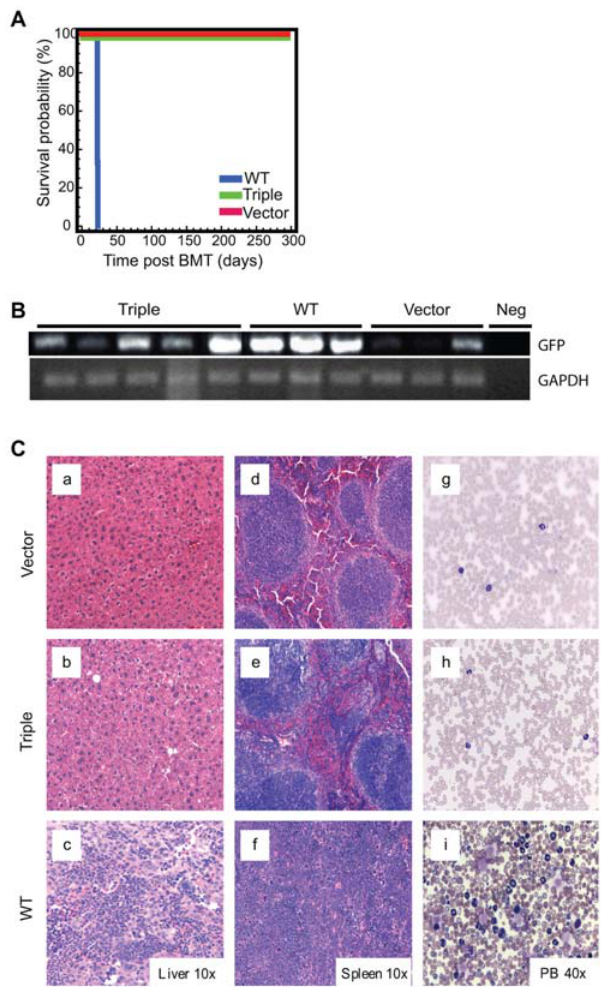
Figure 8. BCR-ABL triple mutant fails to induce leukemia in mice. Murine bone marrow transplantation studies were performed, transplanting bone marrow infected with retroviral supernatant from MIG-BCR-ABL-wild type, MIG- BCR-ABL-triple mutant or MIG vector alone, into lethally irradiated recipients. Mice were monitored post transplant for signs of disease onset. (A) Survival curves for the three recipient populations. (B) Green fluorescent protein (GFP, upper panel) or glyceraldehyde-3-phosphate dehydrogenase (GAPDH, lower panel) was amplified by RT-PCR from RNA purified from spleens of triple mutant, wild type or vector only recipients and visualized on agarose gels. (C) H&E stain from the liver (a–c), spleen (d–f) and Wright/Giemsa stain from peripheral blood smear (g–i) of representative mice at harvest; vector only (upper panels), triple mutant (center panels) and wild type (lower panels).